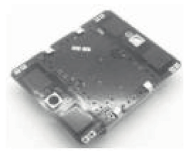
Figure 3: The physical map of the radar